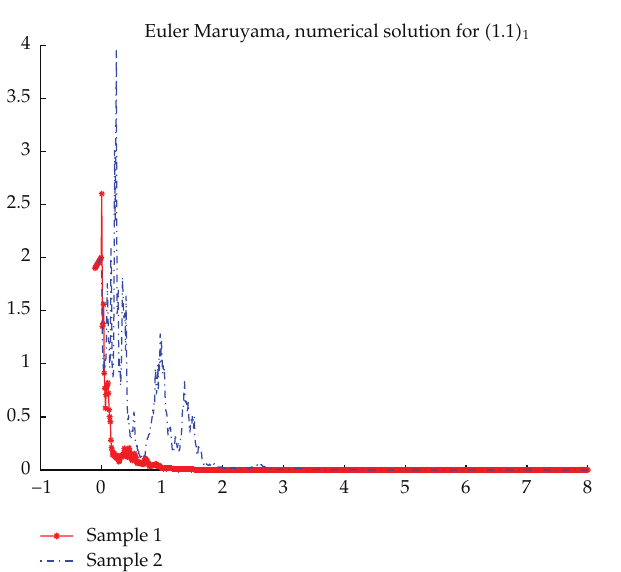
Figure 1: We choose h (cid:5) a (cid:5) b (cid:5) 1 / 4, q (cid:5) 2, σ (cid:5) 1 in (cid:3) 1 . 1 (cid:4)